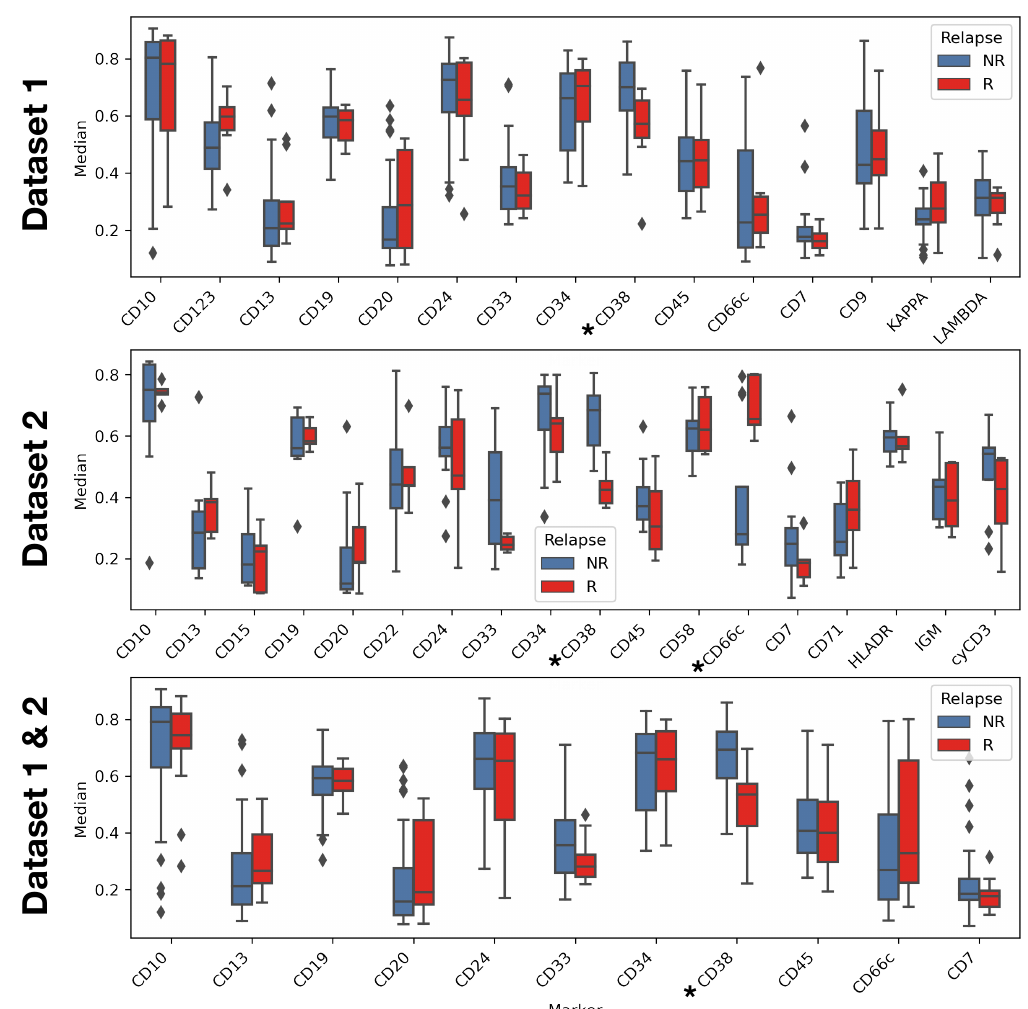
Figure 5. Median of immunophenotypic markers for relapse and non-relapse patients. Comparison was performed via t -test. Asterisk denotes markers with p -value lower than